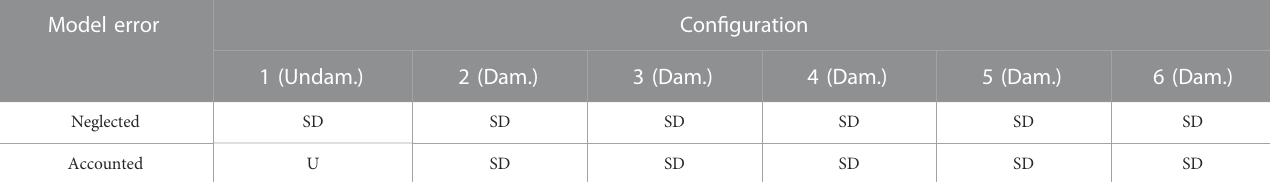
TABLE 8 ASCE benchmark structure: results of the test with the experimental data. U: undamaged; LD: light damage; SD: severe damage. Model